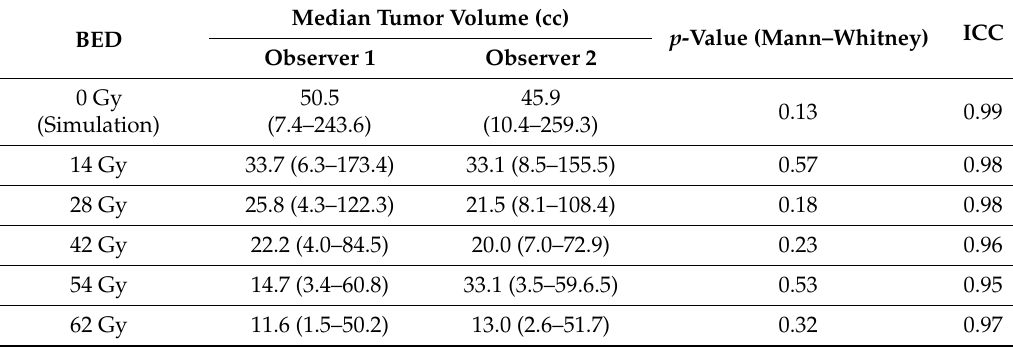
Table 3. Results of inter-observer variability to varying of the different BED levels.